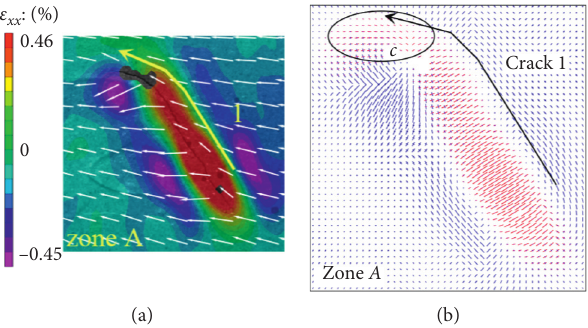
Figure 12: Cracks in mixed opening-sliding mode t � 16.67h. (a) Contour map of strains ε strains in zone A